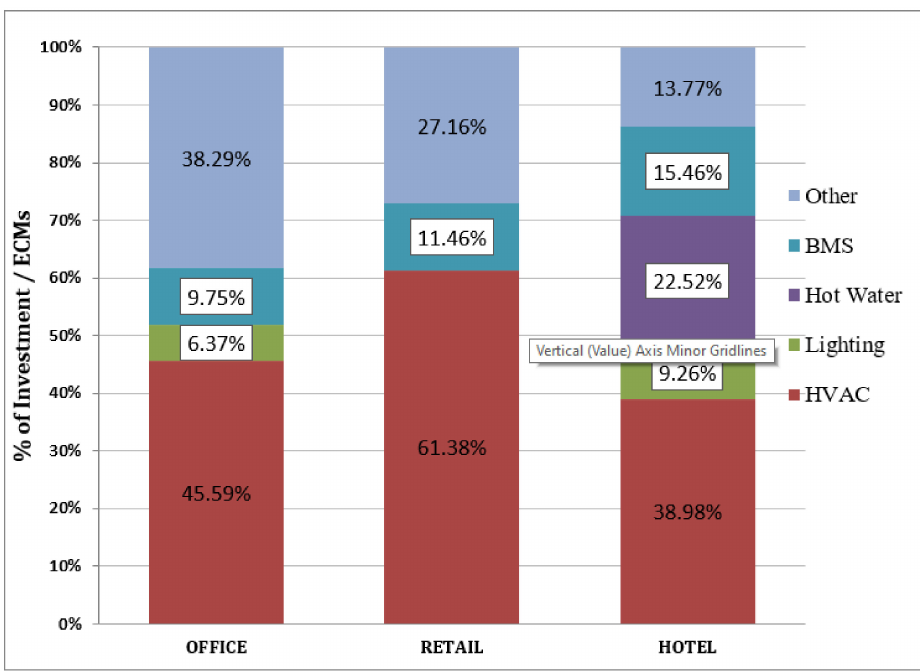
Figure 7. Proportion of total investment per ECM category